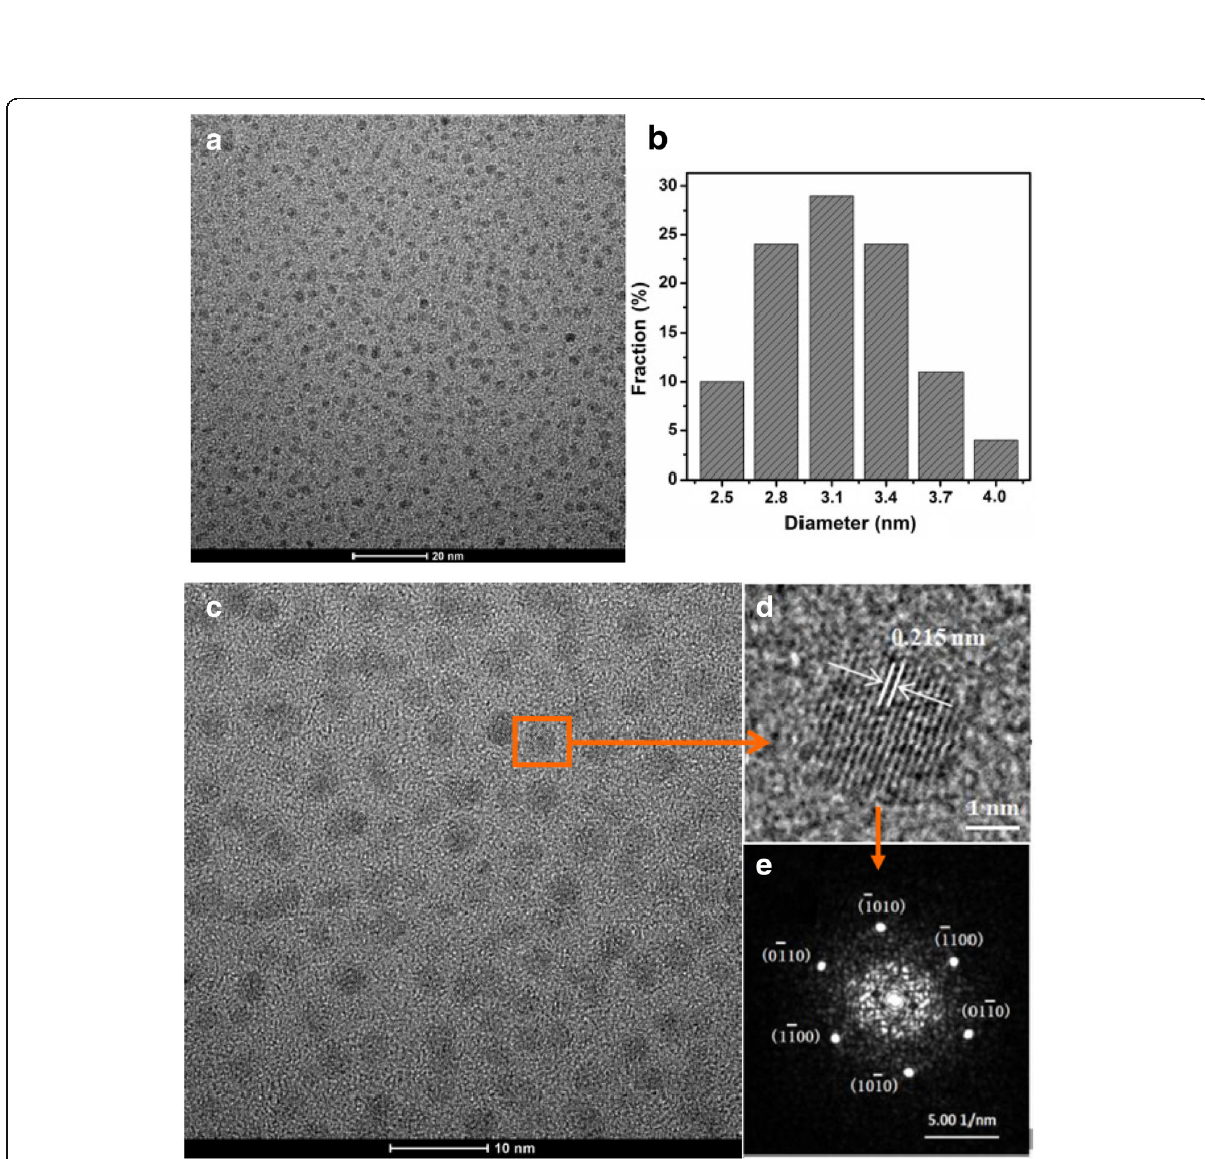
Fig. 2 a , c , d TEM image. b Particle size distribution of CQDs. e The corresponding FFT pattern of